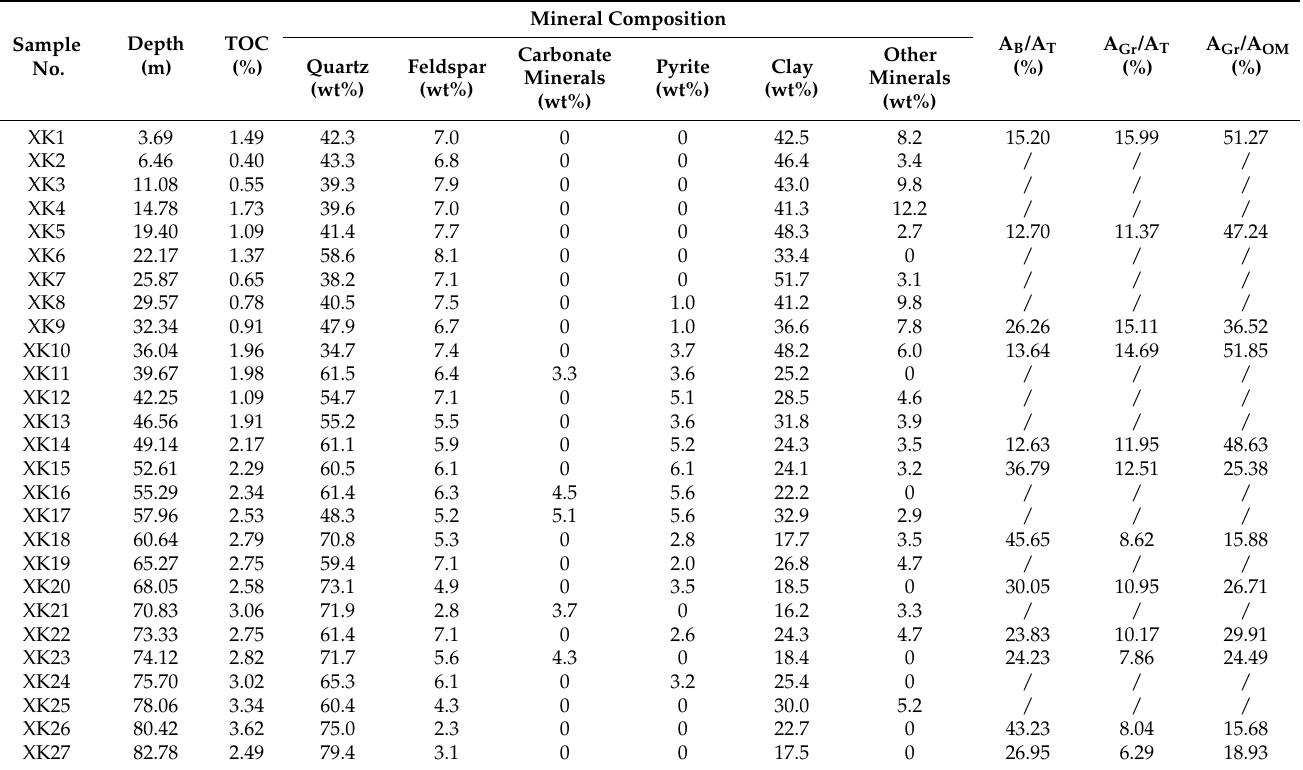
Table 1. TOC values and mineralogical composition of the shales in the Longmaxi Formation.